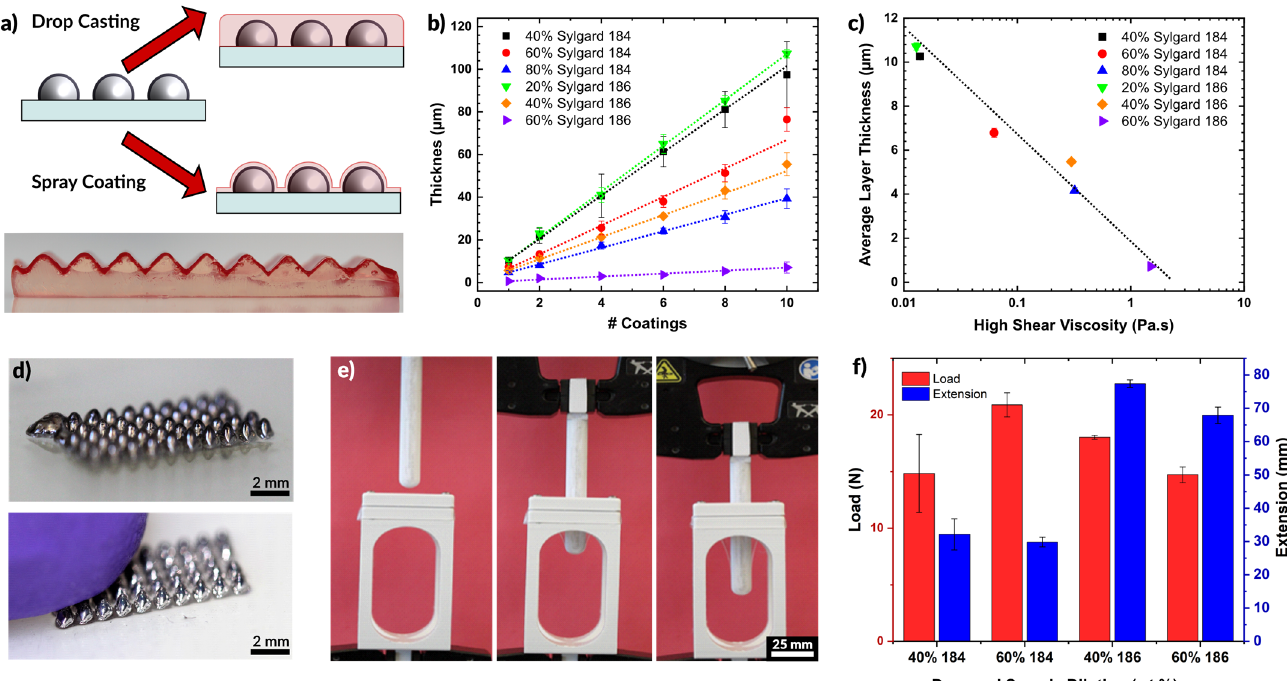
Figure 5. ( a ) Schematic depiction of coating of silicone. Drop casting produces a uniformly level surface while spray coating follows the profile of existing features. PDMS colored with red dye is shown coating an un-dyed PDMS substrate with topography. ( b ) Layer thickness of cured PDMS films for varying dilutions of Sylgard 184 and Sylgard 186. The layer thickness increases with additional coatings. ( c ) Plot of the average layer thickness for each sample in (b) plotted against the viscosity of the dilute solution (i.e., before spraying). Layer thickness decreases for higher viscosity fluids. ( d ) Liquid metal cones, deposited by printing, which are encased in PDMS by spray coating. The encapsulation is optically transparent, but robust to protect the liquid metal from the probing finger. ( e ) PDMS film strength experimental setup. A film is loaded between two clamps at the top of the open structure and the probe is lowered down measuring the force and extension. ( f ) Bar plot showing the average load and extension at rupture for a set of 200 μ m PDMS films prepared by spray coating.